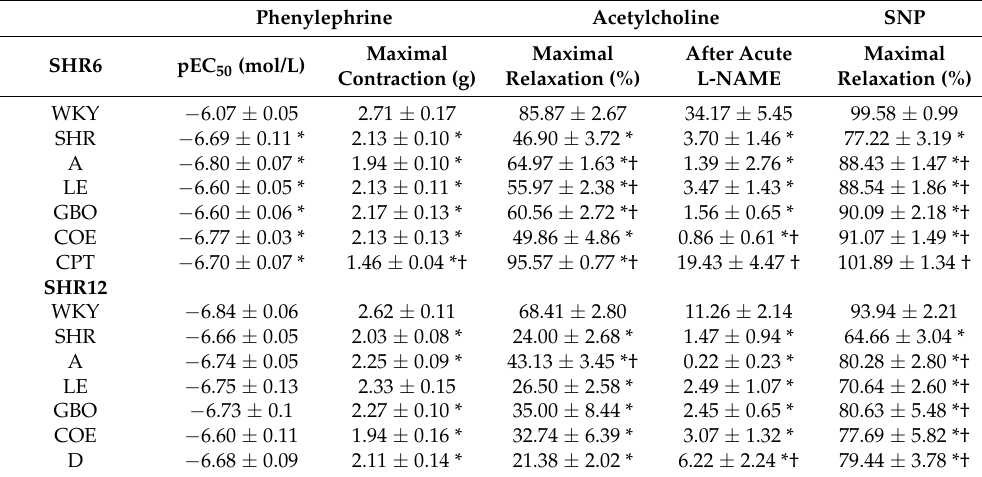
Table 4. Aortic vascular reactivity in the experimental groups.